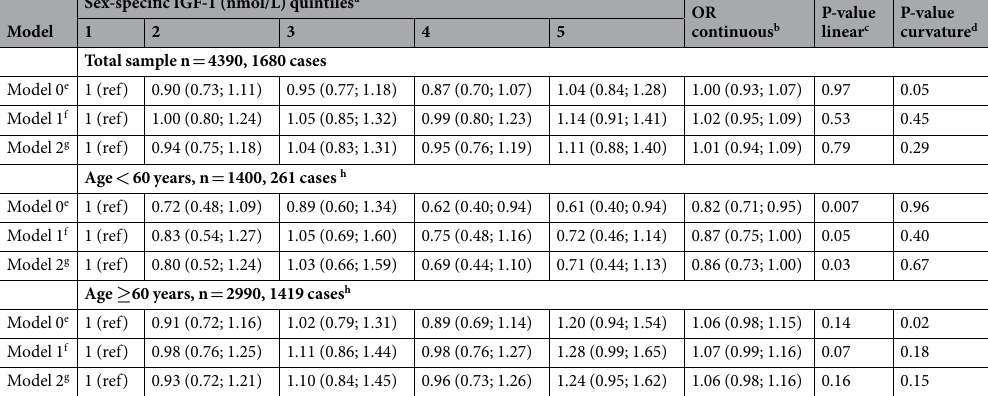
Table 2. Odds ratios (95% confidence interval) for hearing impairment in 2014 in relation to mean values of IGF-1 measured in 2008 and 2012: the English Longitudinal Study of Ageing (n = 4390). a IGF-1 (nmol/L) range in each quintile in the total sample: 3–12.5; 13–15; 15.5–17.5; 18–21; 21.5–52 (men) and 4–11; 11.5–13.5; 14– 15.5; 16–19; 19.5–43 (women). Range in the younger group: 3–13.5; 14–16; 16.5–18; 18.5–21; 21.5–34.5 (men) and 4.5–12; 12.5–14.5; 15–17; 17.5–20; 20.5–43 (women). Range in the older group: 4–12; 12.5–15; 15.5–17.5; 18–20.5; 21–52 (men) and 4–10.5; 11–13; 13.5–15; 15.5–18; 18.5–38 (women). b Odds ratio (95% confidence